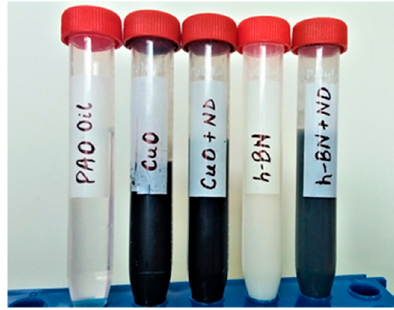
Figure 1. PAO base oil and four combinations of nanolubricants prepared, namely: (i) PAO + CuO, (ii) PAO + CuO + ND, (iii) PAO + h-BN and (iv) PAO + h-BN +